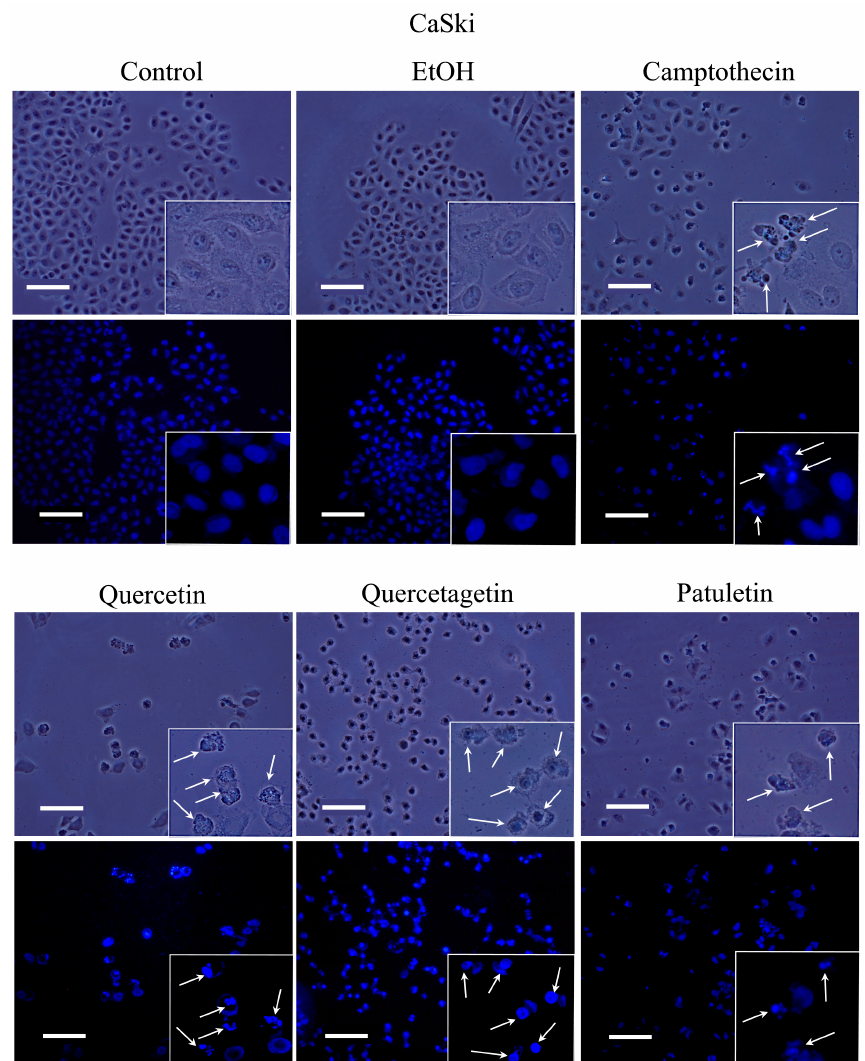
Figure 6. Morphology and DAPI staining. CaSki cell cultures were exposed to quercetin, quercetagetin and patuletin at the aforementioned IC 50 values. Camptothecin was used as a positive control for apoptosis. The phase-contrast images evidenced cellular shapes under the different experimental conditions. The control and EtOH cells had extended cytoplasm with chromatin distributed in the nuclear space, as shown by the fluorescent distribution of DAPI. After treatment, both the cytoplasm and nucleus were contracted, and several apoptotic bodies were visible (arrows), Scale bars 100 microns.